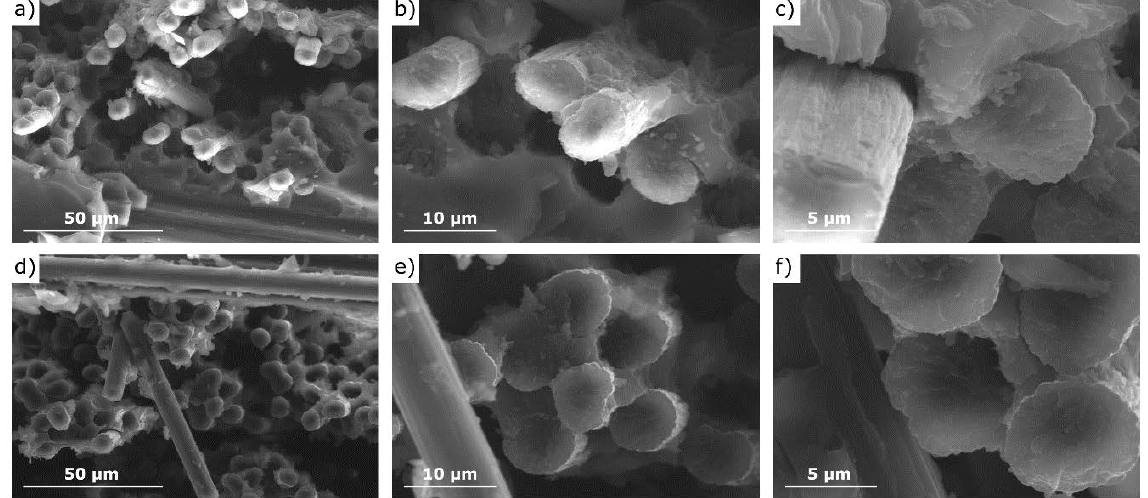
Figure 8. SEM images of the fractured surfaces of ( a – c ) the reference sample and ( d – f ) the sample with 0.3% GO